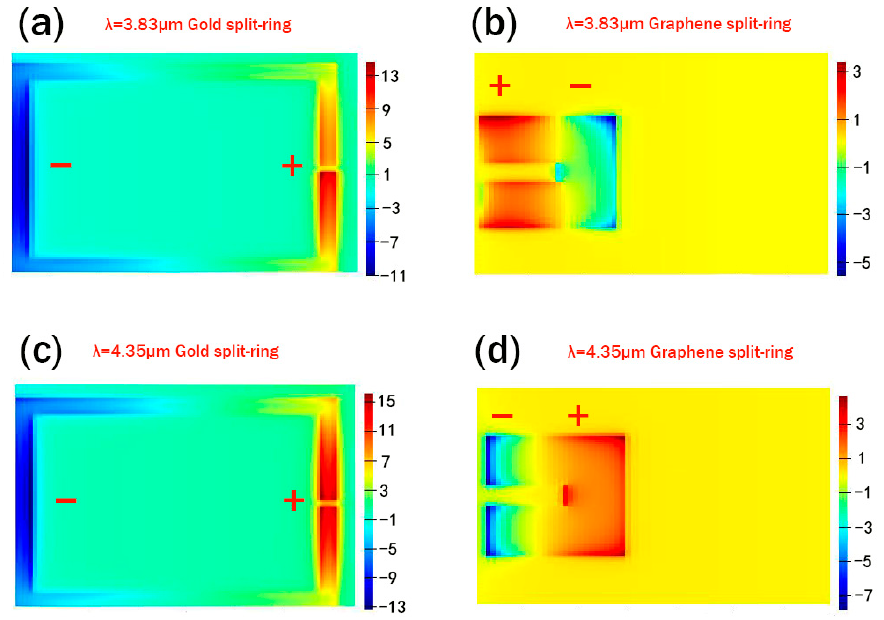
Figure 5. z-component distributions of the electric field under x-polarized continue light excitation at ( a ) λ = 3.83 µ m (Au power monitor), ( b ) λ = 3.83 µ m (graphene power monitor), ( c ) λ = 4.35 µ m (Au power monitor), ( d ) λ = 4.35 µ m (graphene power monitor).